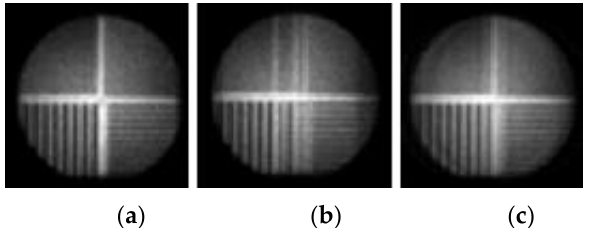
Figure 7. Gamma radiation nuclear imaging system’s results: ( a ) the reference image from a one pinhole system; ( b ) the captured image of the 1-D pinhole array system; ( c ) The reconstructed image of the 1-D pinhole array system with better sensitivity efficiency (improvement factor of 2.333) and better SNR.